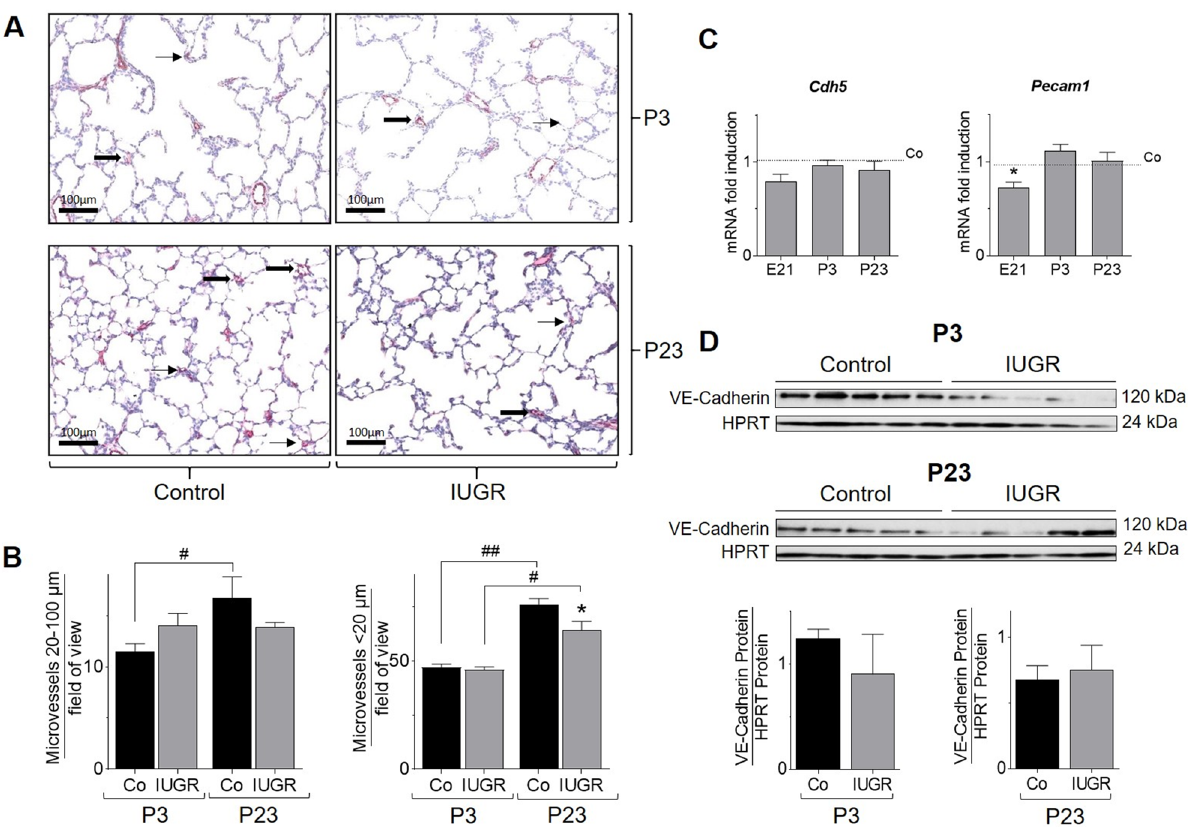
Figure 2. Intrauterine growth restriction (IUGR) impairs angiogenesis. ( A , B ) Representative images (×20 magnification) of pulmonary microvessels (0–100 µm) on postnatal day 3 (P3), and on postnatal day 23 (P23). Random lung sections were stained with von Willebrand Factor as an indicator of endothelial cells, followed by counting of microvessel count for vessels with a diameter of 20-100 µm (marked with ), and vessels with a diameter < 20 µm (marked with ). The respective quantification is shown below the immunhistochemical stainings (n = 6/group). ( C ) Assessment of mRNA expression of pulmonary endothelial cell markers, VE-Cadherin ( Cdh5 ) and CD31 ( Pecam1 ) on embryonic day 21 (E21), P3 and P23 using qRT- PCR; Glyceraldehyde 3-phosphate dehydrogenase ( Gapdh ) served as housekeeping gene; the control group was set at 1. ( D ) Measurement of protein abundance using immunoblot; the respective densitometric quantification of protein expression of VE-Cadherin on P3 and P23 is shown below the immunblots; VE-Cadherin was related to the loading control HPRT (n = 5–6/group). Mean ± SEM. A non-parametric T-test was used to compare IUGR to the control group,*p < 0.05. Comparison between P3 and P23 with a two-way ANOVA test, # p < 0.05, ## p <